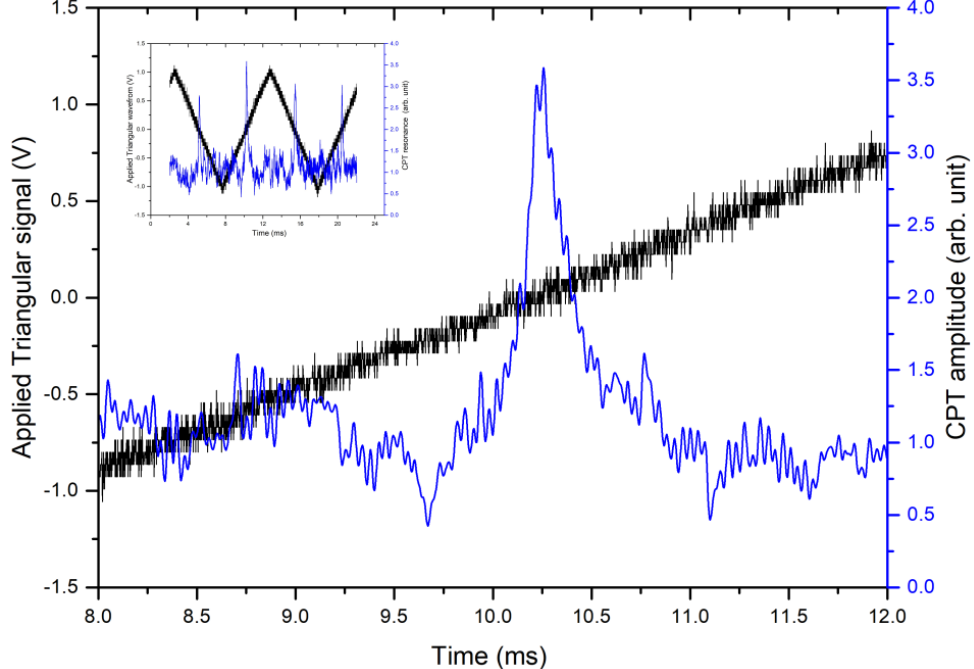
Figure 5. CPT resonance when ω is detuned around 87 Rb : . F = 2, m F = + 1 F ′ = 1, m F = 0 | ⟩ → | ⟩ ± The FWHM of the resonance was calculated to be 168 Hz, which corresponds to a magnetic field of 24 nT. The inset shows the CPT signal with the scanning triangular waveform. Note that the horizontal axis is in units of milliseconds; this unit has been taken directly from the oscilloscope and, with the use of FPI, it is converted to actual frequency and thus to units of magnetic field unit. Previous studies related to properties and sensitivities of CPT resonances have re- ported a much narrower resonance linewidth as compared to our present result